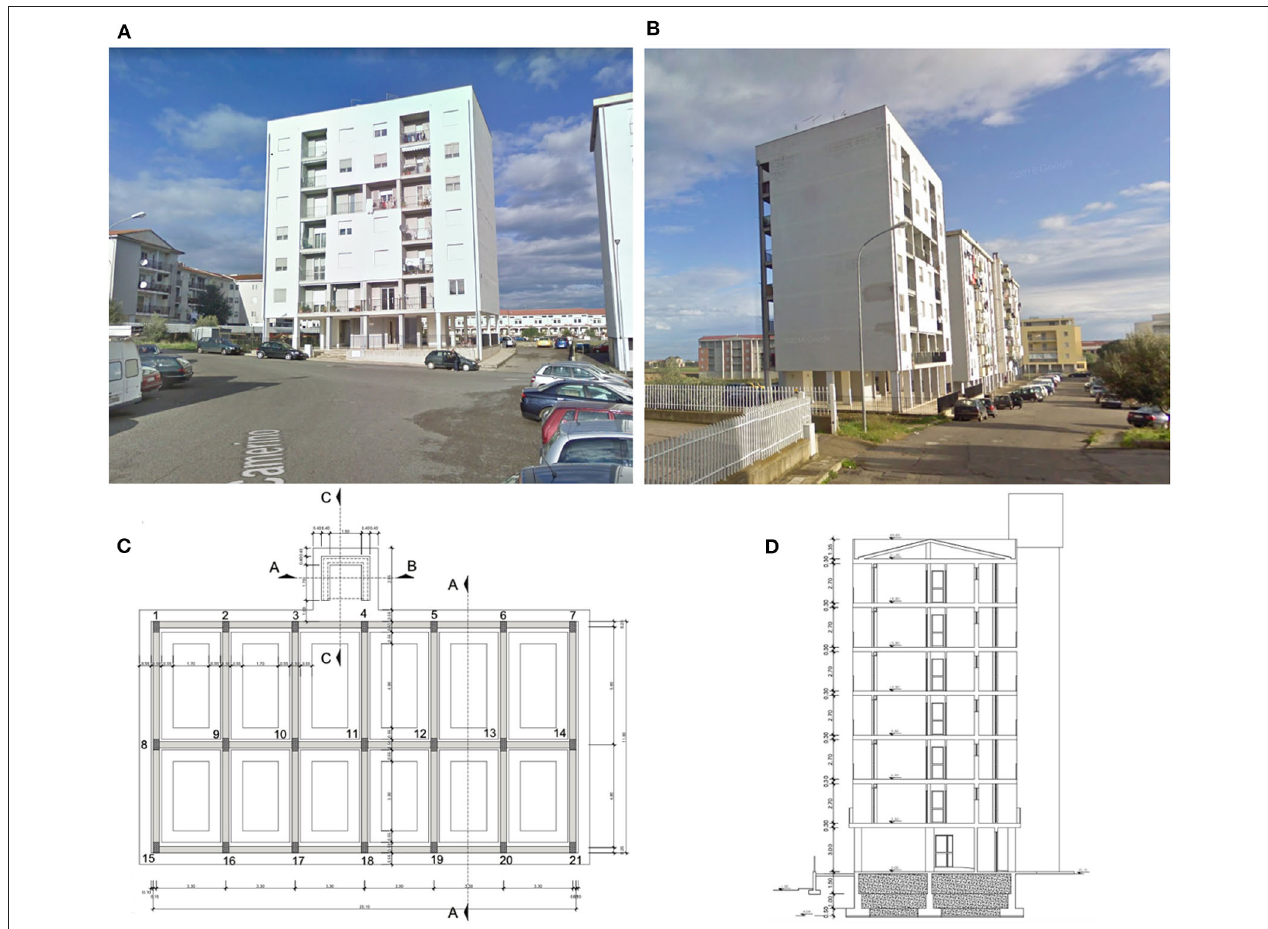
FIGURE 1 | (A,B) Prospective views of the case study, (C) foundation beams plan and (D) transverse section in the “as built”